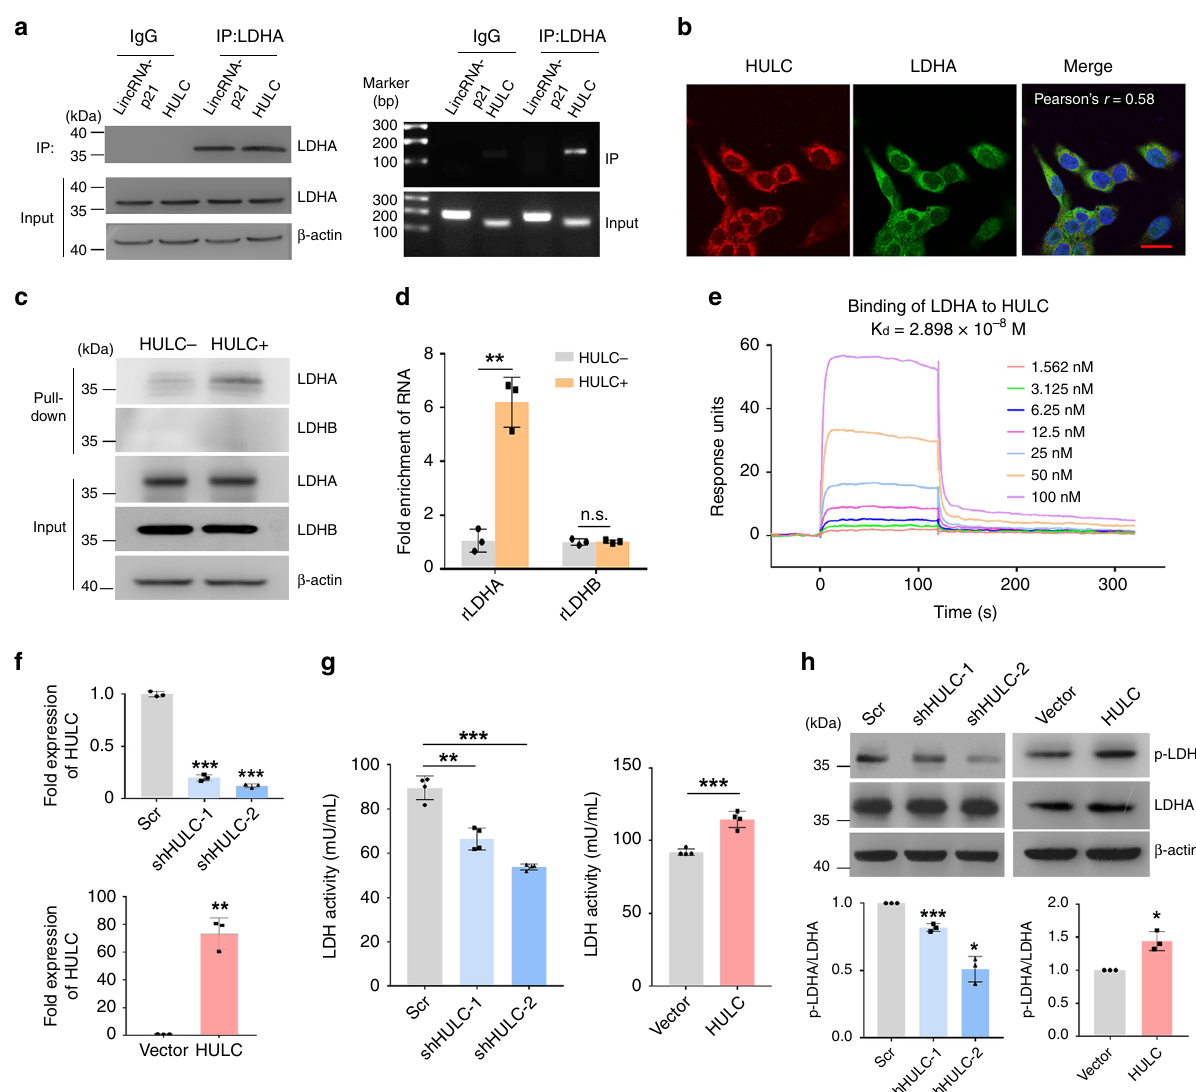
Fig. 3 HULC interacts with the glycolytic enzyme LDHA. a Validation of the interaction between LDHA and HULC. Immunoblots of LDHA in the cell lysates and immunoprecipitates of LDHA are shown in the left panel. Agarose gel electrophoresis images of HULC ampli fi ed by qRT-PCR are shown in the right panel. LincRNA-p21 was examined as the RNA control. b The cellular localizations of HULC and LDHA were analyzed by combining RNA-FISH and immuno fl uorescence. Cell nuclei were stained with DAPI, and the scale bar was 20 μ m. c Biotinylated HULC was incubated with HepG2 cell lysate and then isolated by streptavidin-conjugated beads. LDHA and LDHB in the cell lysate and RNA pull-down were examined by western blotting. Biotinylated antisense HULC was used as the control. d His-tagged rLDHA or rLDHB was incubated with Dynabeads ® His-tag isolation magnetic beads, respectively. Next, in vitro transcribed HULC or antisense HULC was incubated with the beads. Then, the RNA-protein complexes were isolated, and the levels of HULC were examined using qRT-PCR. Data represent the mean ± s.d. of triplicate independent experiments (*** P < 0.001, n.s., not signi fi cant, by two-sided Student ’ s t test). e The mol e cular interaction between LDHA and HULC was analyzed to measure the dissociation factor K d . f The levels of HULC in HepG2 cells with HULC knockdown (upper panel) or overexpression (lower panel) were measured by qRT-PCR. Data represent the mean ± s.d. of triplicate independent experiments (*** P < 0.001, by two-sided Student ’ s t test) g The LDH activities of HepG2 cells with HULC knockdown (left panel) or overexpression (right panel) were examined by a lactate dehydrogenase activity assay kit and compared with the same number of corresponding control cells. Data represent the mean ± s.d. ( n = 4 independent experiments, *** P < 0.001, by two-sided Student ’ s t test). h HULC was silenced or overexpressed in HepG2 cells. The levels of p-LDHA (Y 10 ) and LDHA in the cell lysates were detected by western blotting. Band intensities were measured by ImageJ. Data represent the mean ± s.d. of triplicate independent experiments (* P < 0.05, *** P < 0.001, by two-sided Student ’ s t test). See also Supplementary Fig. 4. Source data are provided as a Source data fi